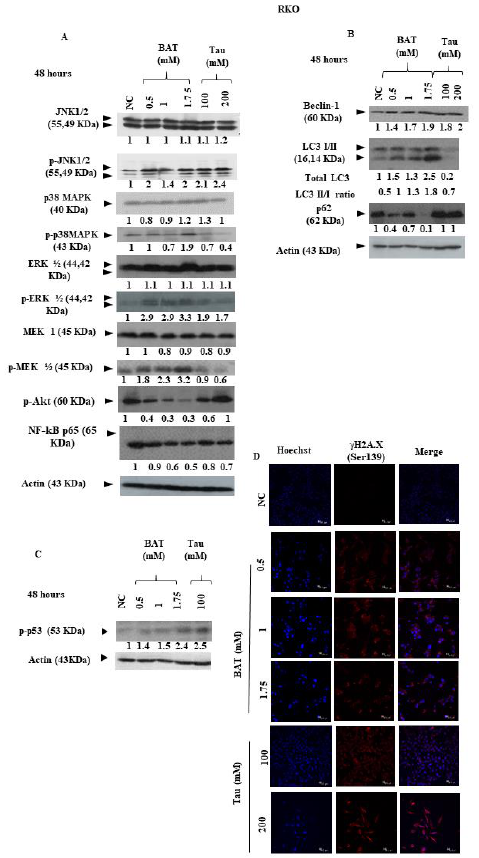
Figure 8. Both BAT and Tau affect the MAPK signaling pathway, autophagy, and DNA damage response (DDR) of RKO cells: ( A ) cells were treated with 0.5–1.75 mM BAT or 100–200 mM Tau for 48 h, versus negative control (NC). The total expression profiles of JNK½ , p-JNK½ (Thr183/Tyr185), p38 MAPK, p-p38MAPK (Thr180/Tyr182), ERK½ , p-ERK½ (Thr202/Tyr204), MEK-1, p-MEK½ (Ser217/Ser221), p-Akt (Ser473), NF-kB were determined by immunoblotting. β-actin was used as a loading control. The whole gel figures are shown in Figure S4 while quantification and statistical analysis are shown in Figure S7 and Table S10; ( B ) RKO cells were treated with (0.5–1.75 mM) BAT or (100–200 mM) Tau for 48 h, versus negative control (NC). The expression profiles of Beclin-1, LC3I/II, p62 were determined by immunoblotting. The whole gel figures are shown in Figure S4 while quantification and statistical analysis are shown in Figure S7 and Table S10. ( C ) RKO cells were treated with (0.5–1.75 mM) BAT or 100 mM Tau for 48 h, versus the negative control (NC). The expression profiles of p-p53 (Ser15) were determined by immunoblotting. β -actin was used as a loading control. The whole gel figures are shown in Figure S4 while quantification and statistical analysis are shown in Figure S7 and Table S10. ( D ) Immunofluorescence staining for γ H2A.X (Ser 139) after treatment with (0.5–1.75 mM) BAT or (100–200 mM) Tau for 48 h versus negative control (NC). Hoechst was used to stain the cell nuclei (magnification × 400). Quantification and statistical analysis are shown in Figure S7 and Table